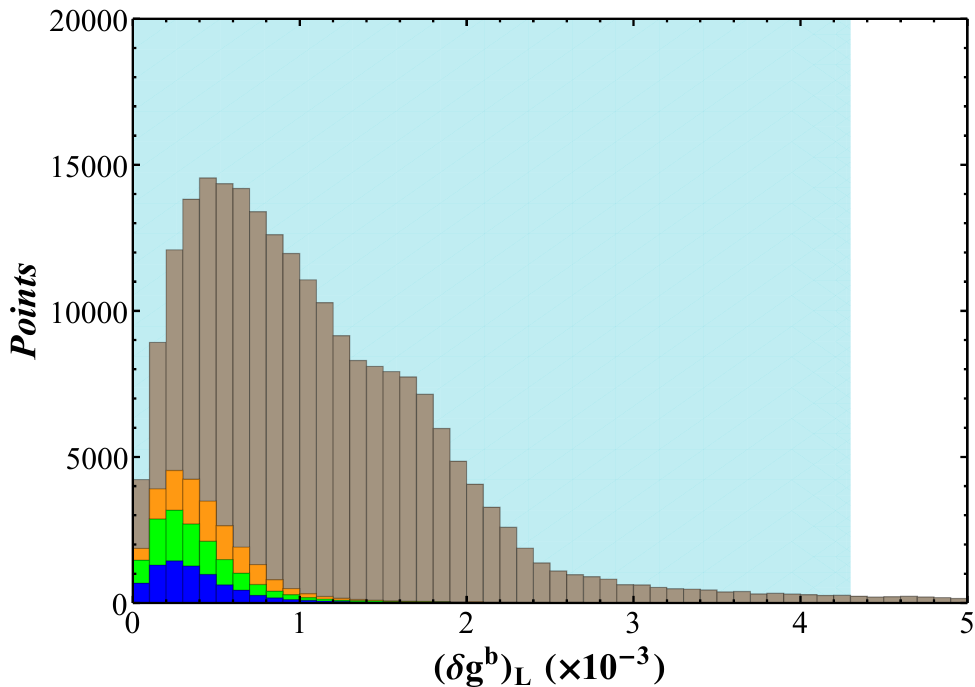
Figure 17. A histogram of (cid:14)g bb for all parameter space points (beige), those within the 99.7% L CL region of the h (cid:0) (cid:27) d plane (orange), within the 95% CL region (green), and within the 68% CL region (blue). The light blue region denotes the region (cid:14)g bb < 0 : 0043, or the region in which the L contribution to this parameter from our model is no greater than the maximum bound of the